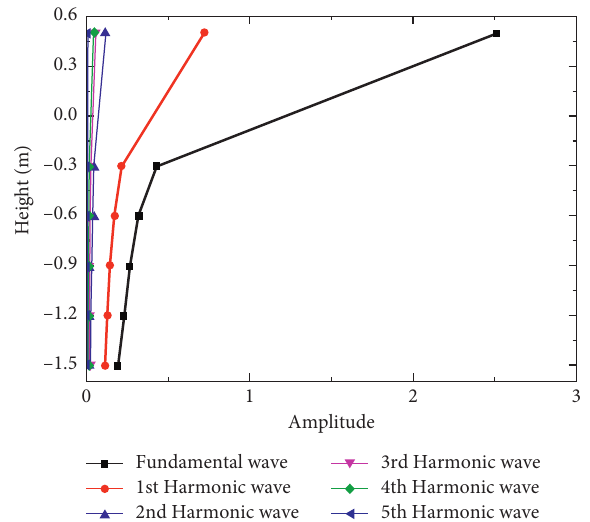
Figure 19: Different harmonic wave amplitudes in different buried depths.